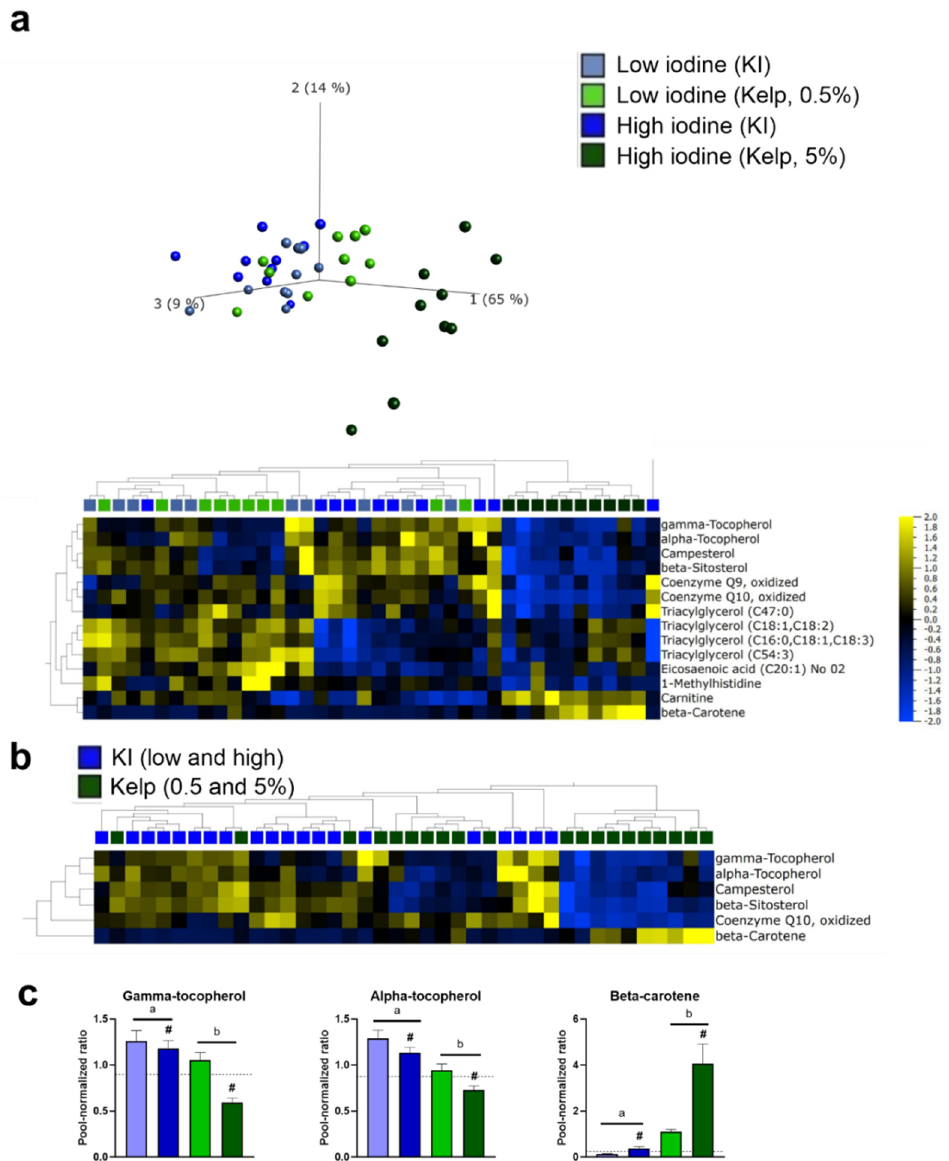
Figure 7. ( a ) PCA including 681 liver metabolites measured in liver tissue harvested after 13 weeks of dietary treatment. Heatmap and hierarchical clustering of liver metabolites differently regulated between iodine sources and doses (q-value < 0.05) ( b ) Heatmap and hierarchical clustering of liver metabolites different between iodine sources (q-value < 0.05). Data were visualised, and statistical tests were performed using Qlucore Omics Explorer. ( c ) Selected metabolites with potential antioxidant activity regulated in rats fed low and high KI and sugar kelp diets. Measured levels were semi-quantitative and normalised against a reference pool sample ( n = 9–10). Different letters (a,b) in the graph denote significant differences ( p < 0.05) between the iodine sources (kelp, KI), where # indicates a significant difference between the iodine doses (independent of source).